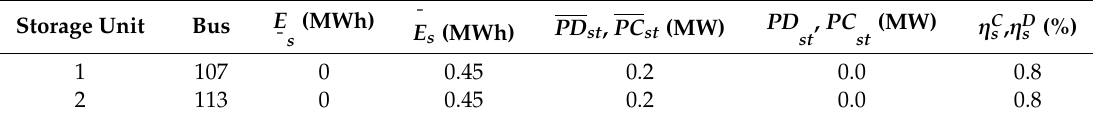
Table 1. Technical data for storage